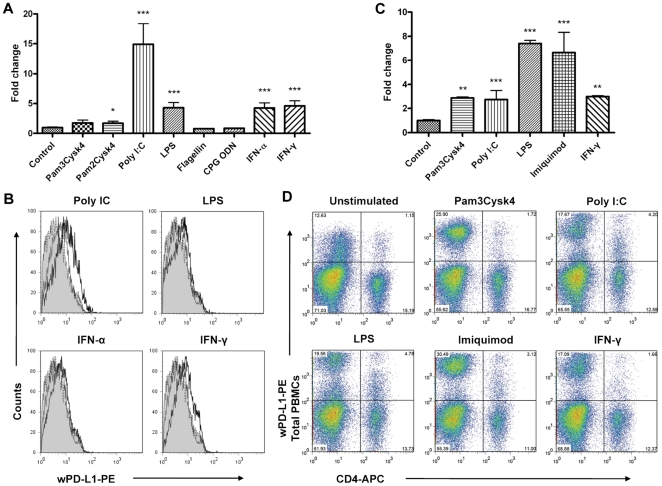
WPD-L1 expression in PWHs and PBMCs stimulated by TLR ligands.PWHs and PBMCs were stimulated with Pam3Cysk4 (2 µg/ml), Pam2Cysk4 (2 µg/ml), PolyI∶C (12.5 µg/ml), LPS (12.5 µg/ml), flagellin (10 µg/ml), imiquimod (10 µg/ml), CpG ODN (12.5 µg/ml), woodchuck IFN-α (500 U/ml), or -γ (500 U/ml). The copy numbers of wPD-L1 transcripts in PWHs (A) or PBMCs (C) were detected by real time RT-PCR after 6 h stimulation. PD-L1 protein expression on PWHs (B) or PBMCs (D) was determined by FACS staining. Shadows, isotype control antibody stained PWH; hairline, unstimulated PWH; normal lines, stimulated cells. The statistical analysis was performed for the samples treated with TLR ligands and to the unstimulated control. The statistical significance of the results was given as P values: *, p<0.05; **, p<0.005; ***, p<0.0005.